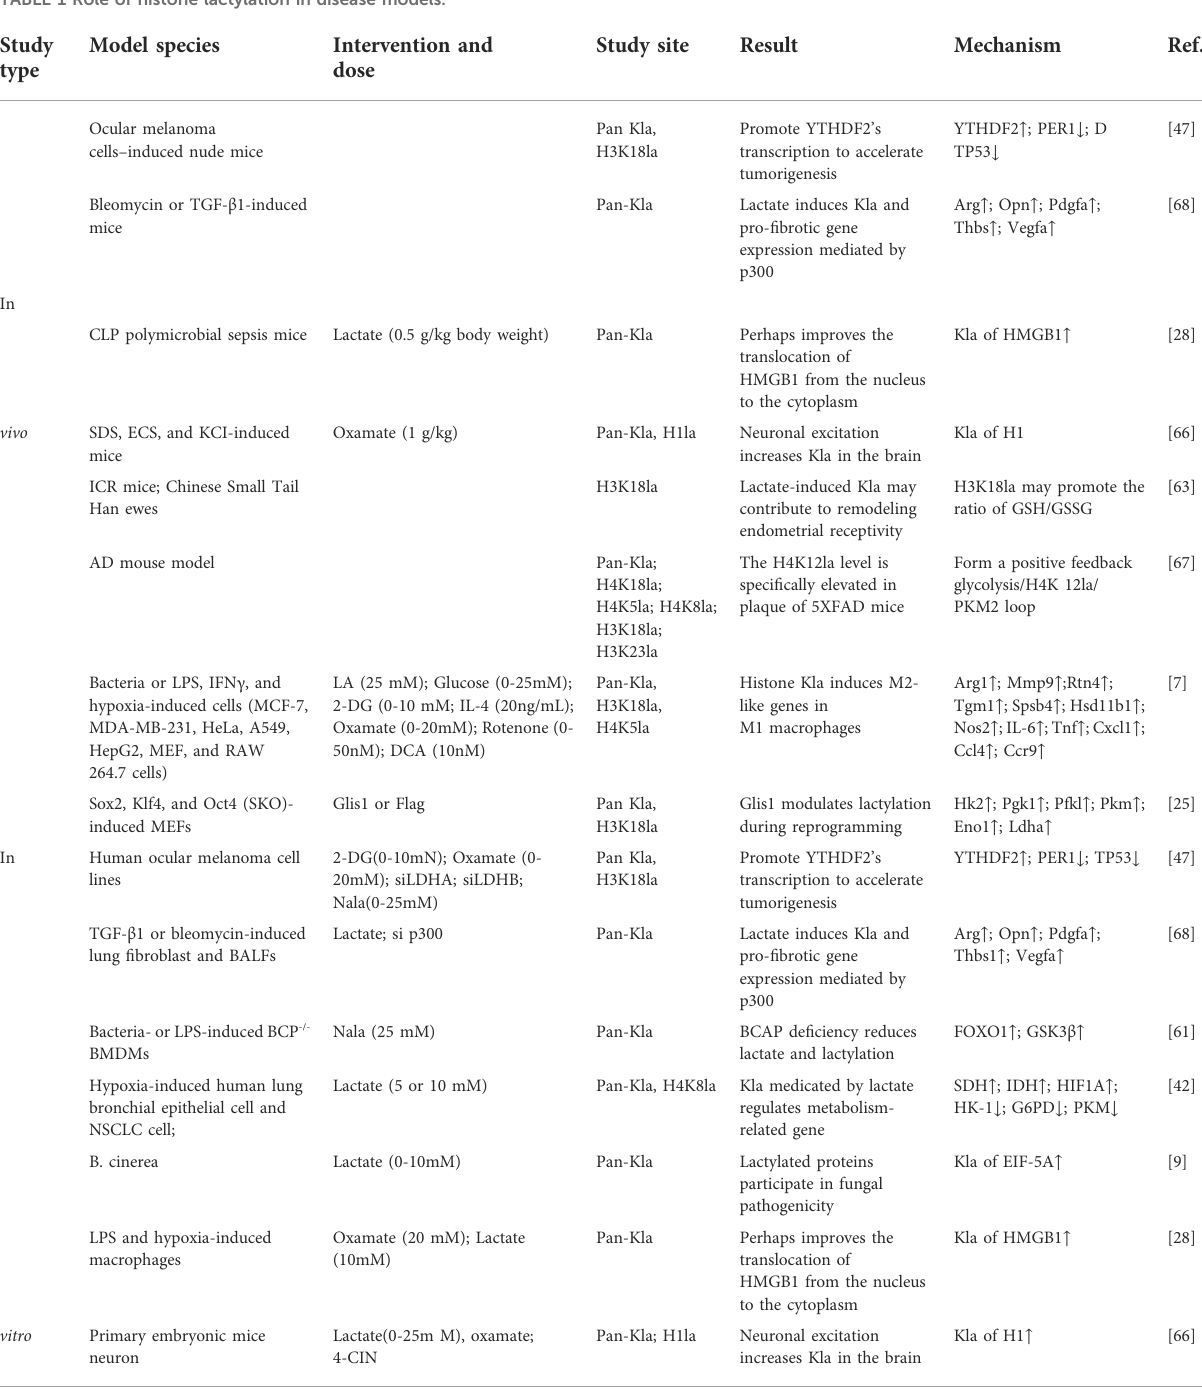
TABLE 1 Role of histone lactylation in disease